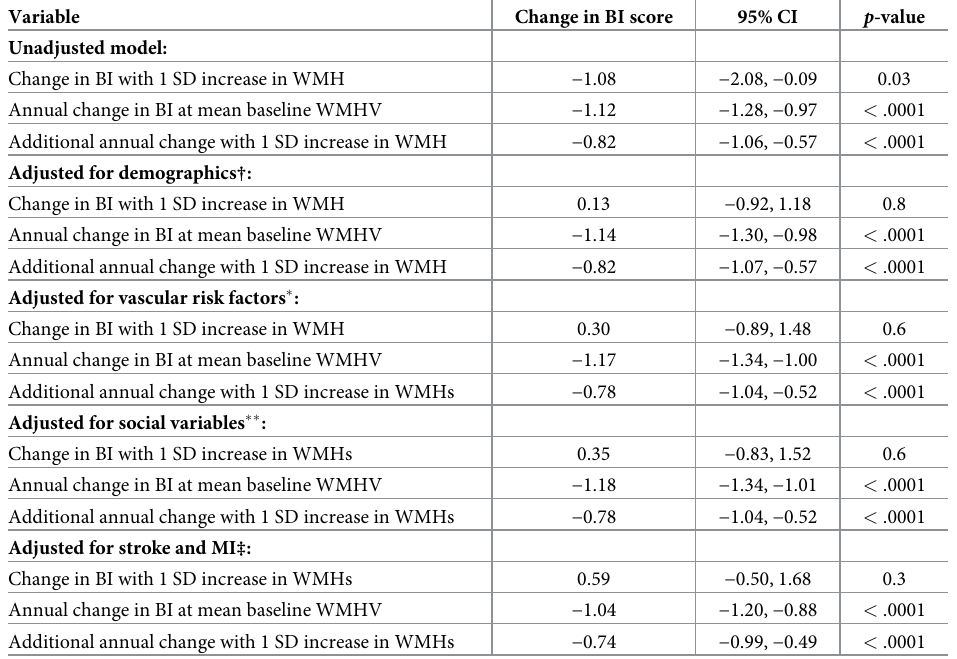
Table 2. Unadjusted and adjusted models of the association between standardized whole brain white matter hyperintensity volume (WMHV/TCV (cid:3) 100) and functional status.